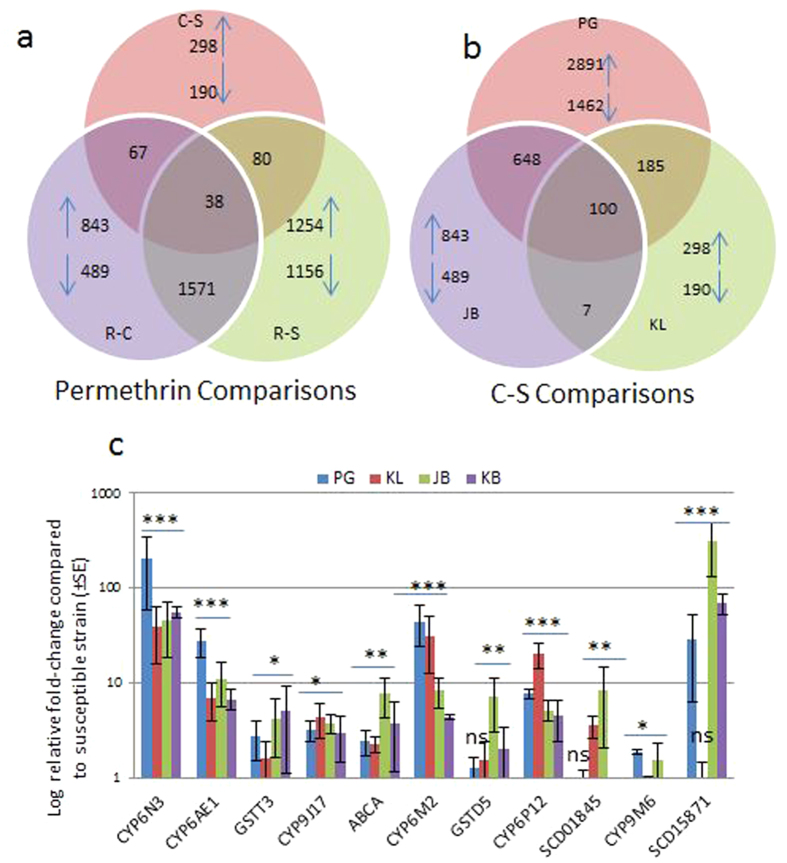
Transcription profiling of Ae. albopictus in Malaysia: (a) Summary of probes differentially expressed for permethrin comparisons for the Kuala Lumpur (KL) population, whereas (b) is for C-S comparisons from KL (Kuala Lumpur), PG (Penang) and JB (Johor Bharu). The Venn diagrams show the number of probes (or ESTs) significantly (P value < 0.01) up- or down-regulated (>2 fold change) in each comparison as well as the commonly expressed probes. Upward arrows indicate up-regulated probes while downward represent down-regulated. (c) Differential expression by qRT-PCR of 11 genes up-regulated in microarray in the four locations. Statistical significance is indicated by ***for P < 0.001; **for P < 0.01: *for P < 0.05 and ns is for non-significant of fold-change in comparison to the susceptible strain VCRU.